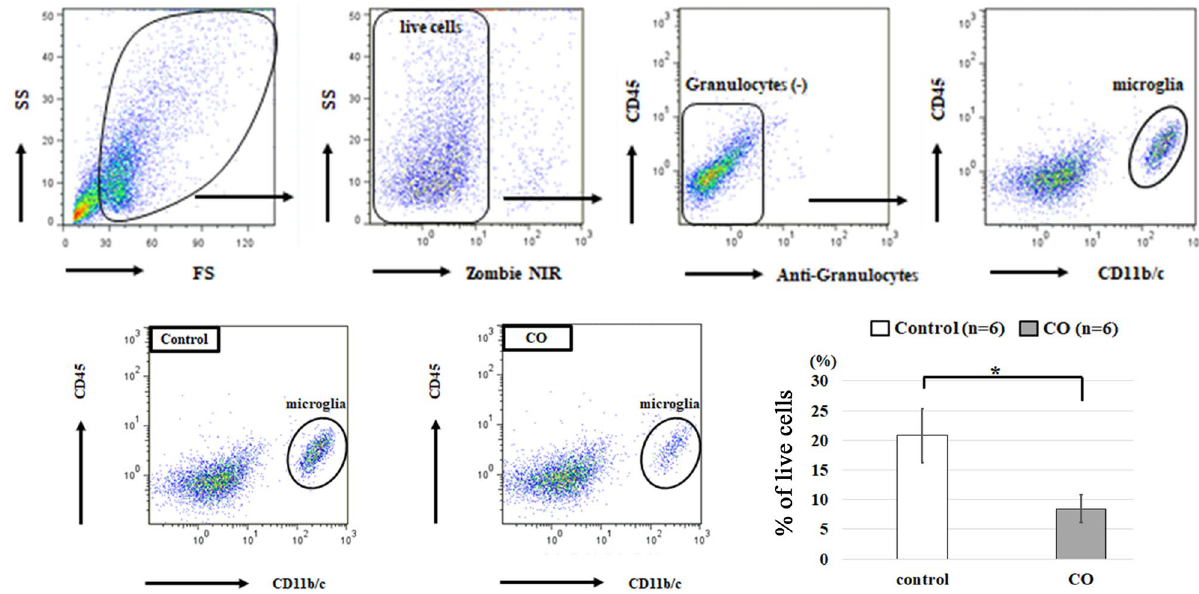
Figure 4. Analyses of microglial cells in the hippocampus at day 21 with flow cytometry (FCM). ( A ) The gating strategy of FCM for analyses of microglial cells. Live cells were gated based on forward scatter (FS) and side scatter (SS) values to remove debris, followed by exclusion of dead cells using Zombie NIR. Live cells were analyzed by separating granulocytes using CD45-PE and granulocytes-FITC. Granulocytes were identified as CD45 hi /granulocyte + cells. Cell populations excluding granulocytes were analyzed by separating microglial cells using CD45-PE and CD11b/c-PE/cy7. Microglial cells were identified as CD45 + /CD11bc + cells. ( B ) Microglial cells identified as CD45 + /CD11bc + cells are decreased in the CO rats compared with controls. ( C ) The percent of microglial cells among live cells is significantly decreased in the CO group. Values are expressed as mean ± SEM. * p < 0.05.